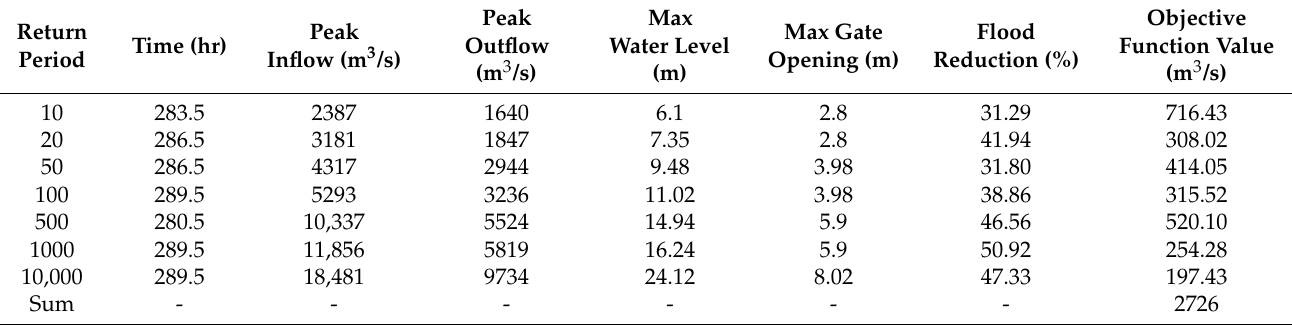
Table 3. Results for ten-stage simulation model of Haktanir and Kisi [18].